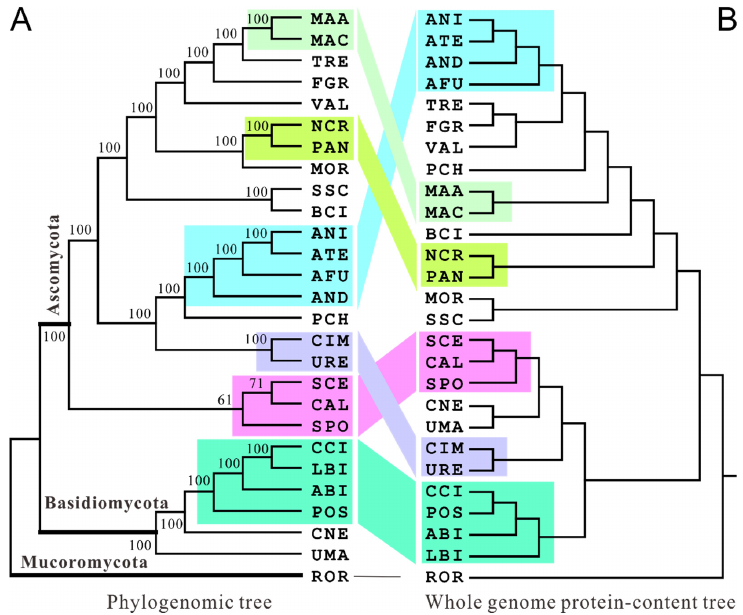
Figure 1. Cophylogenetic analysis of sequence ( A ) and whole genome protein-content-based ( B ) trees. The similarly grouped lineages in both types of trees are highlighted in the same color and connected. The abbreviations of fungal species are listed in Table S1 if not mentioned in the context.